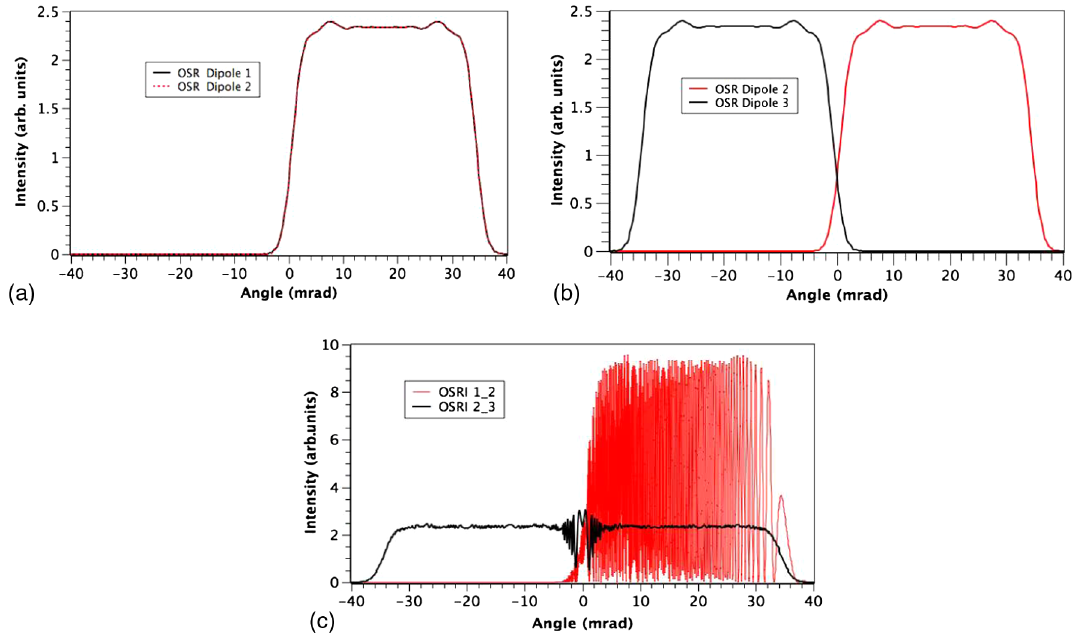
FIG. 3. Far field angular distribution patterns of OSR generated from a 100 MeVelectron passing through two dipoles arranged: (a) in an S configuration (dipoles 1,2); (b) in a U configuration (dipoles 2,3); and (c) corresponding S and U